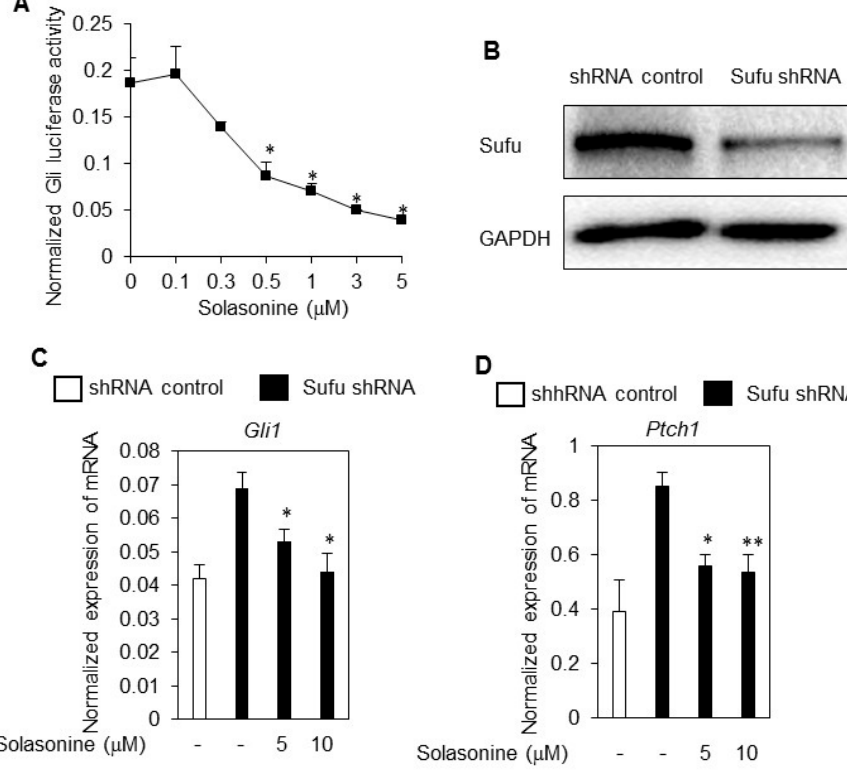
Figure 4 . Cont. Figure 4. Cont